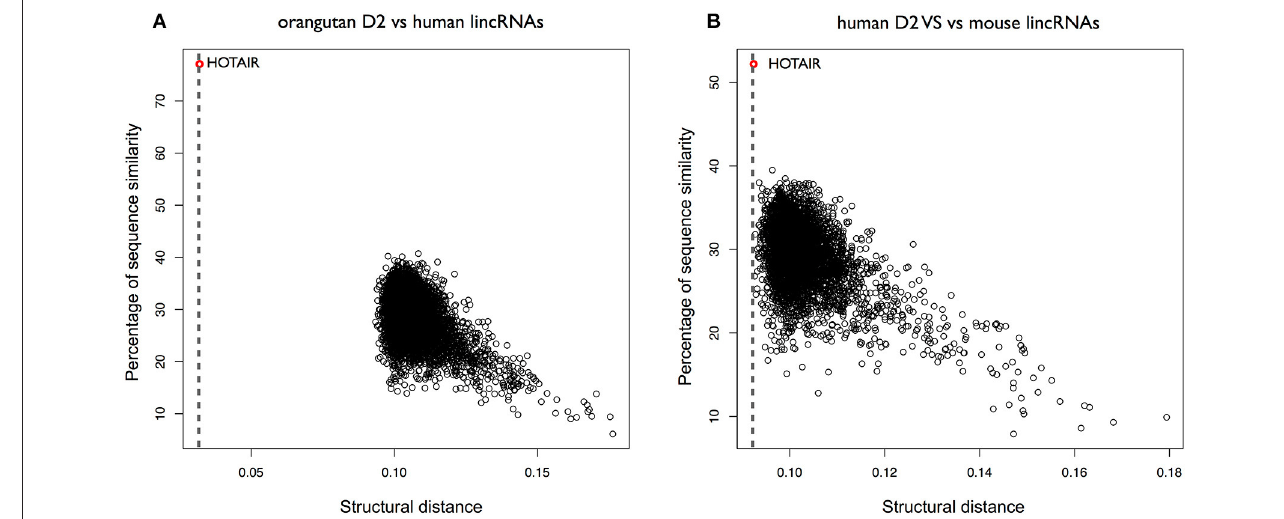
FIGURE 6 | Structural conservation of HOTAIR D2 in different species. (A) Structural similarities of orangutan D2 against all human lincRNAs. The distance was obtained using OBE-DTW and plotted against with the sequence similarity. The D2 of orangutan is identified as the best match (colored in red). (B) Structural similarities of human D2 against all mouse lincRNAs. Human D2 is identified as the best match (colored in red).